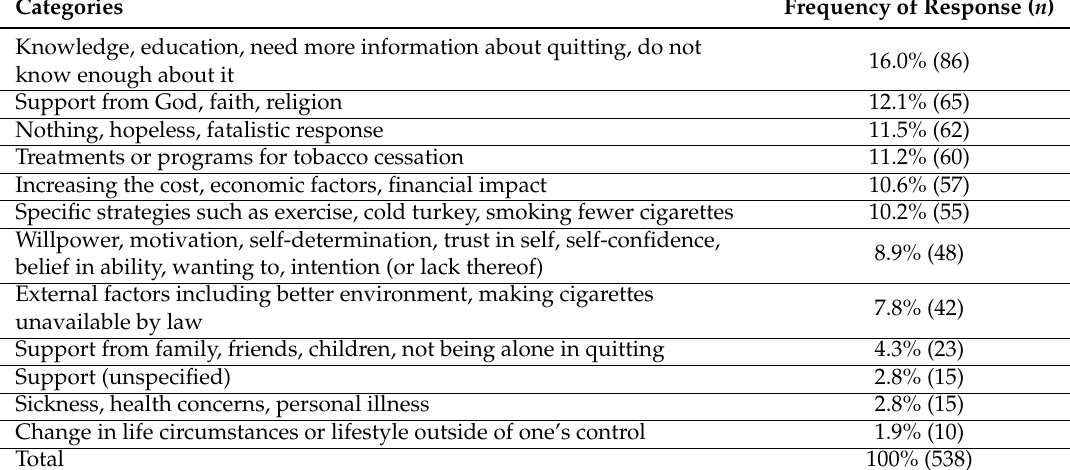
Table 5. Frequency of responses to open-ended question: “What would help you quit tobacco the